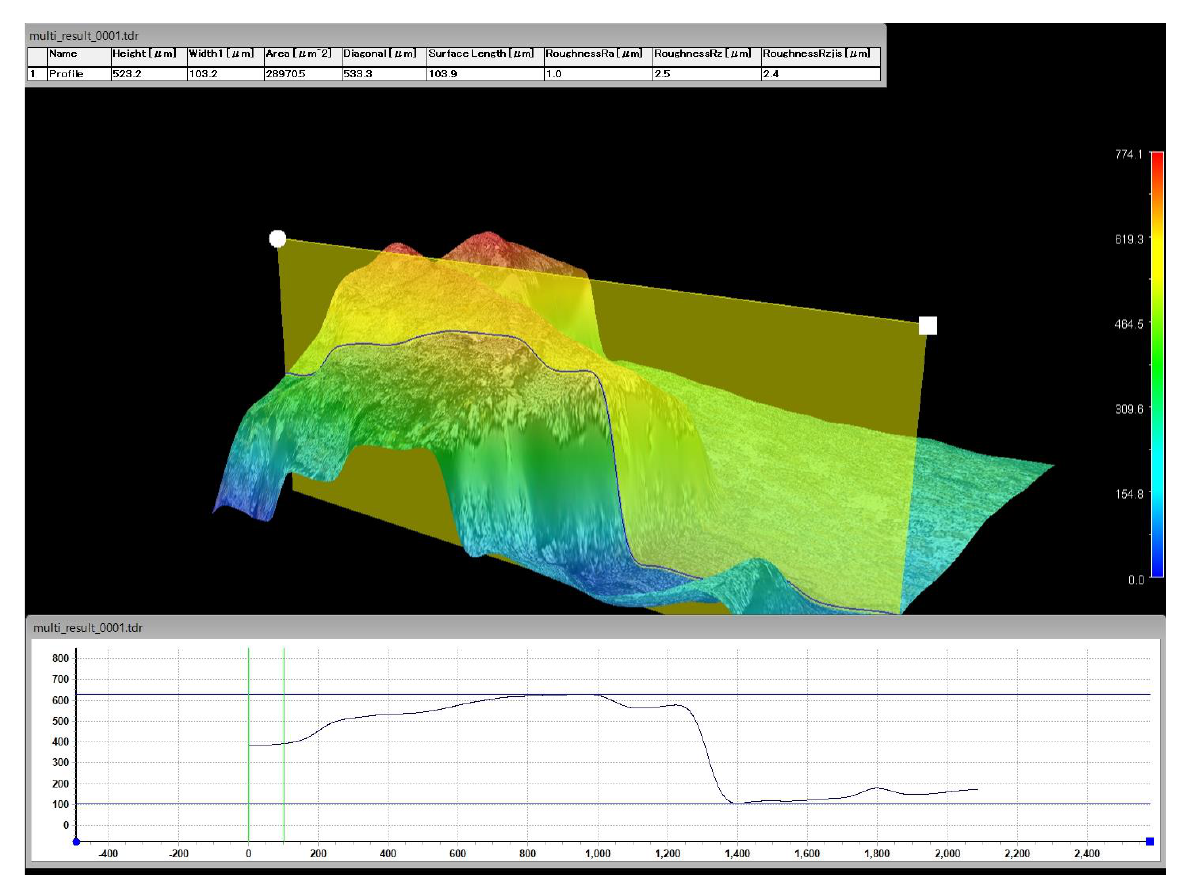
Figure 6. Three-dimensional profile of corrosion damage after checking with a microscope, HIROX RH2200. The result is derived from the profile marked with the yellow line shown in Figure 4.